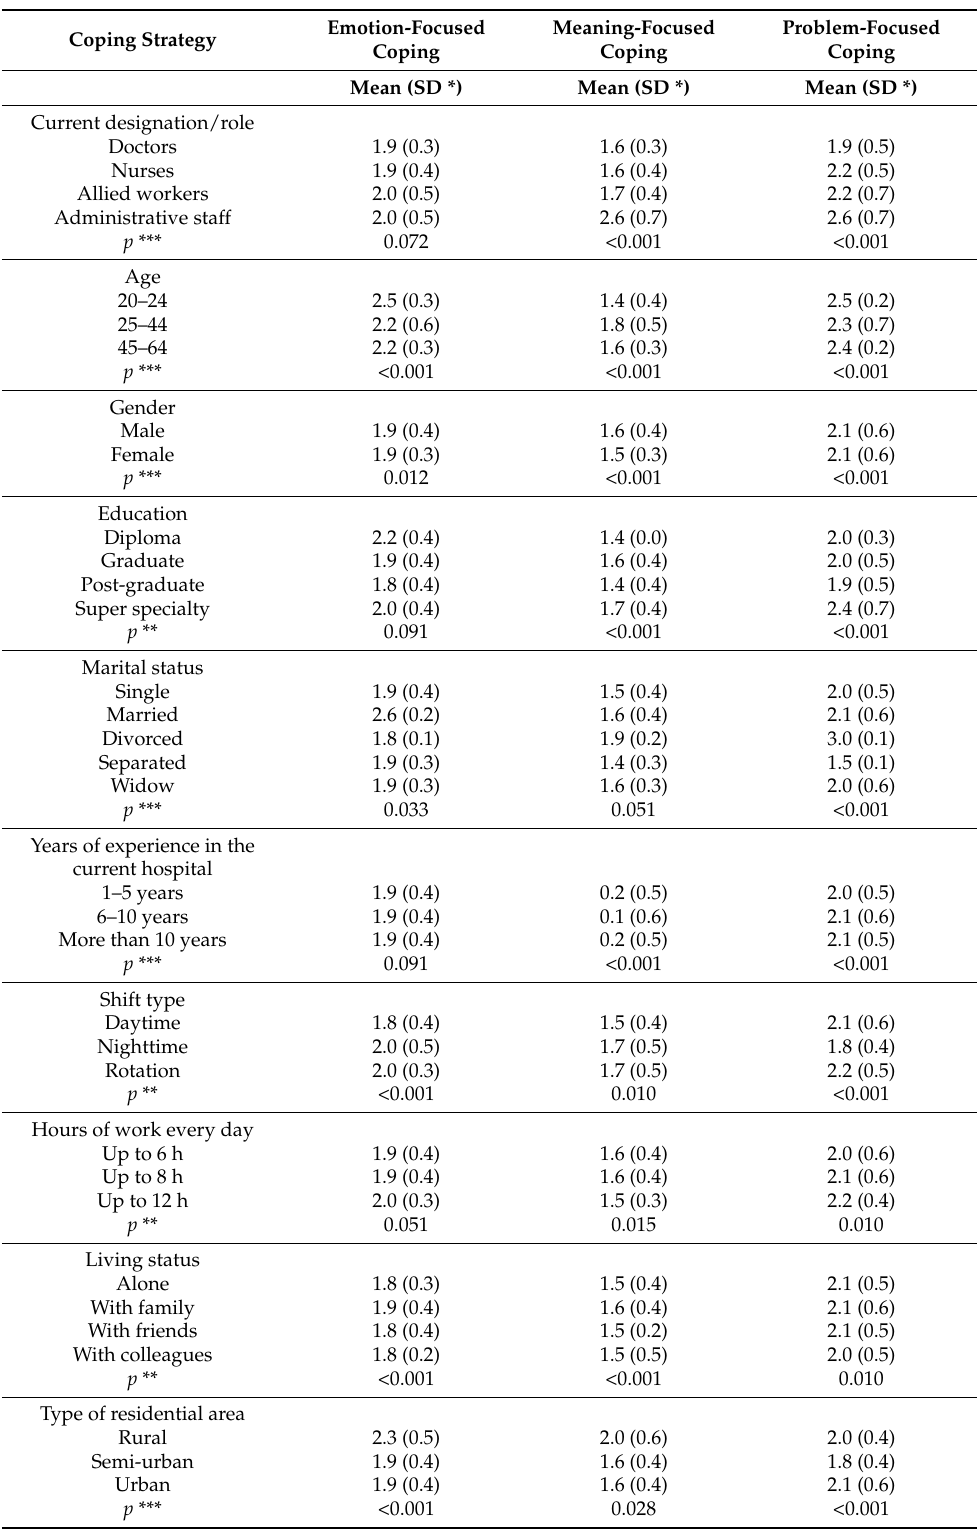
Table 3. Means scores of coping strategies reported by the participants according to demographic